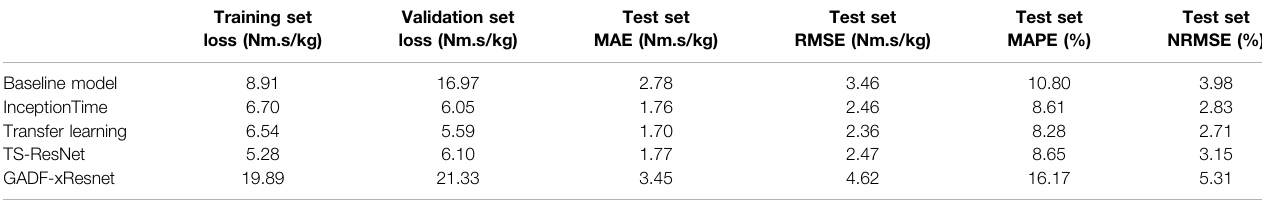
TABLE 2 | Regression models performance.